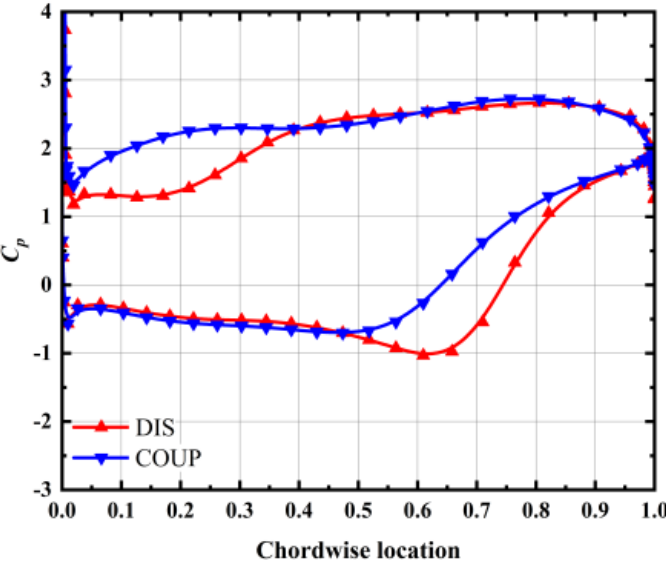
Figure 21. Comparison of blade loading of different conditions at T/4 (95% spanwise location).